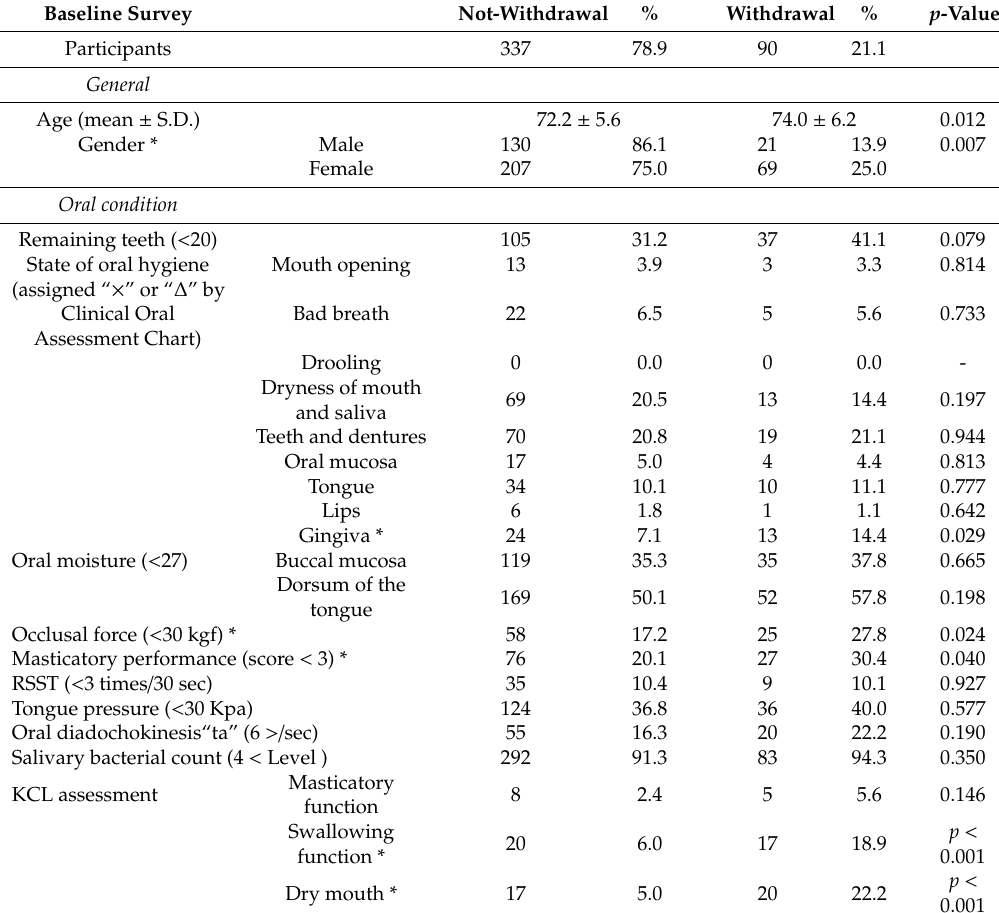
Table 2. A summary of participant information and the relationship between social withdrawal and oral